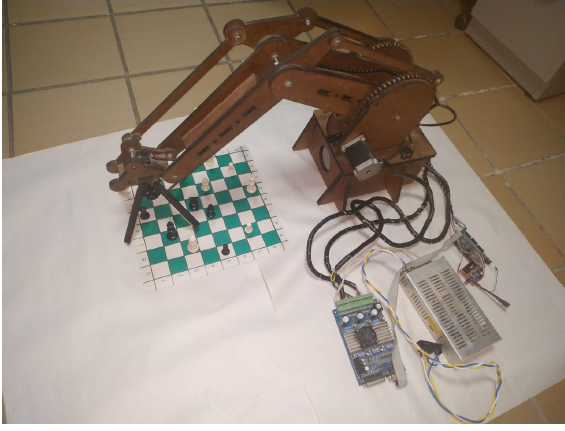
Figure 15. Robotic arm.